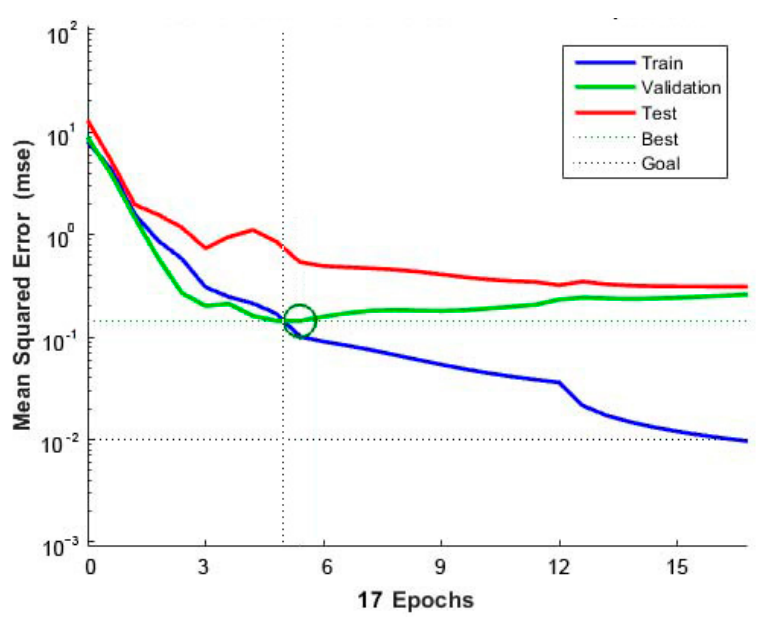
Figure 11. Training results of the artificial neural network (ANN).